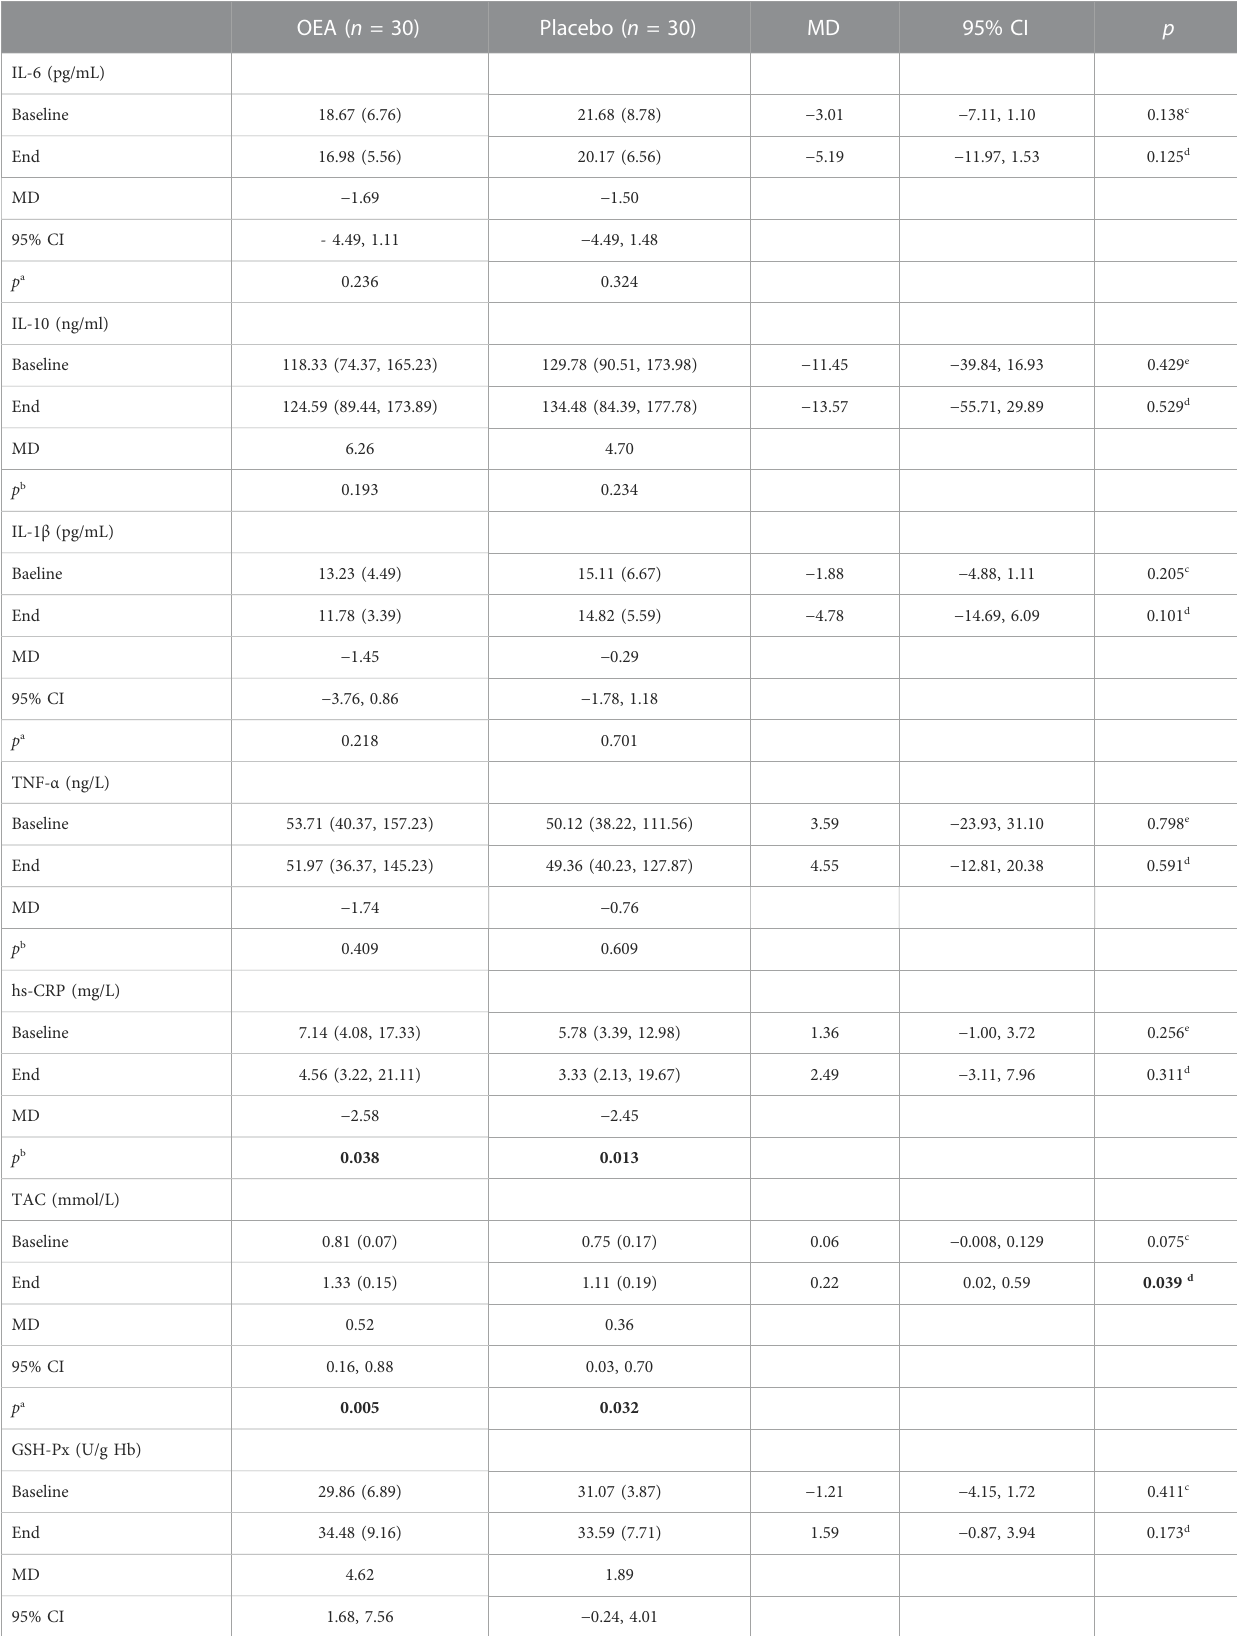
TABLE 3 In fl ammatory biomarkers and oxidative stress/antioxidant parameters of the patients throughout